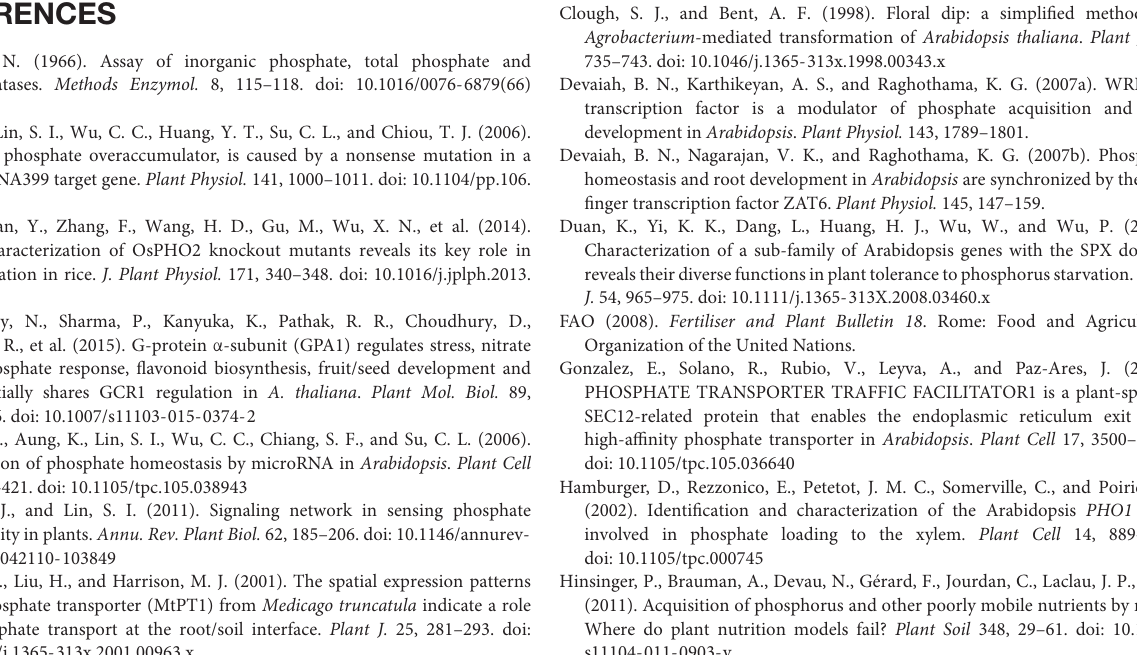
FIGURE S1 | Comparison of phenotype of OsNLA1 transgenic plants. (A) Plant phenotype and (B) shoot biomass content of wild-type, knockdown lines ( osnla1-1 , osnla1-2, and osnla1-3 ) and over-expression lines (OsNLA-OE1, OsNLA-OE2, and OsNLA-OE3) were grown with sufficient nutrients (including optimum nitrate and Pi levels) for 8 weeks in soil-pots. All genotypes showed the same phenotype at both growth stages (4 and 8 weeks after sowing). Data are means ± SD of ten to fifteen replicates ( n = 10–15). FIGURE S2 | Analysis of total P accumulation in shoots and roots of OsNLA1 transgenic lines under sufficient and low nitrate levels. (A) Total P content of shoots and roots of wild-type, knockdown and over-expression lines, grown in hydroponics under sufficient (Control) and low nitrate levels for 4 weeks. Knockdown lines ( osnla1-1 , osnla1-2, and osnla1- 3) had the greatest total P contents in shoots and roots under low nitrate (LN) level. The over-expression lines (OsNLA-OE1, OsNLA-OE2, and OsNLA-OE3) and wild-type had the same amount, except for roots grown in low nitrate. (B) The percent P increase by low nitrate treatment compared to the control. (C) The percent P change of knockdown and over-expression lines by low nitrate treatment, relative to the wild-type. Different letters indicate significant differences at P ≤ 0.05 level (ANOVA, LSD test). Comparison was done for shoots and roots separately. Data are means ± SD of three to five replicates ( n = 3–5). FIGURE S3 | Relationship between applied ammonium in the medium and Pi accumulation in wild-type and Osnla1-1 knockdown lines. Plants were grown in both hydroponics and soil, providing them with optimum Pi (300 µ M and 1 mM, respectively) and different ammonium levels (in hydroponics, 300 µ M being the optimum and 90 µ M was lower than optimum; in soil, 10 mM being the optimum and 1 mM was sub-optimal/low). Low ammonium treatments did not result in accumulating higher Pi levels in the shoot of both genotypes. Different letters indicate a significant difference at P ≤ 0.05 level. Data are means ± SE of three to five replicates ( n =